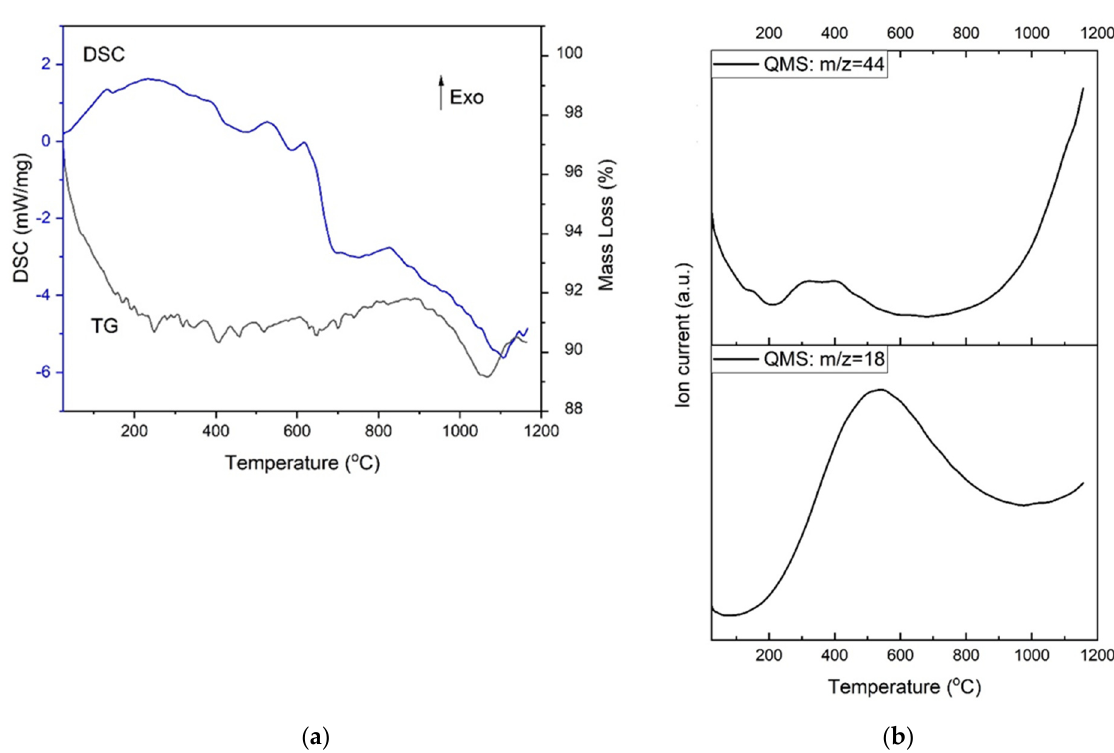
Figure 8. EGA results for the pure filter, where: ( a ) presents DSC-TG signals, and ( b ) shows QMS registered signals. Table 2. Volatile ions released from filters identified by QMS during thermal analysis